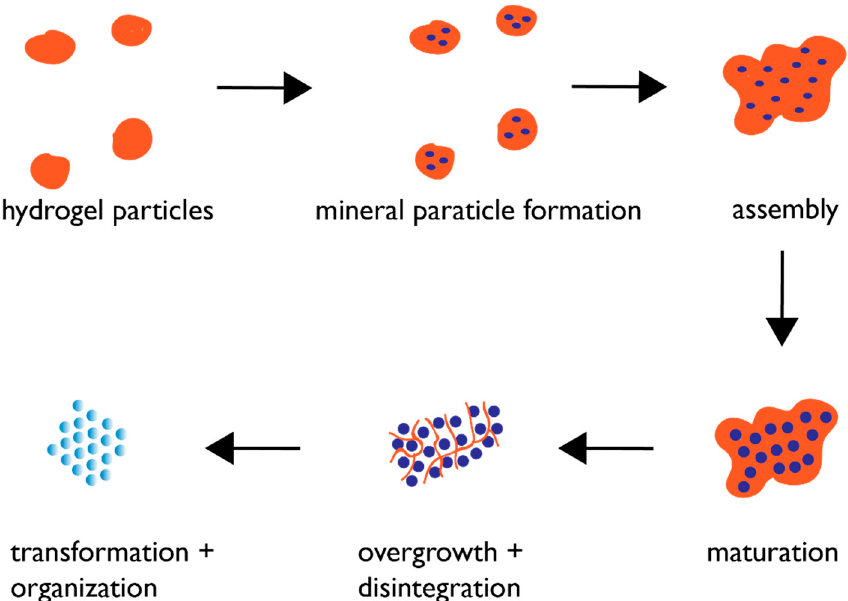
Figure 3. Proposed protein hydrogel pathway for biogenic mesocrystal formation. Blue circles denote mineral nanoparticles. Maturation stage refers to the growth of the ACC nanoparticles to permissible dimensions within the hydrogel matrix. The overgrowth and disintegration stages refer to the continued mineral growth and simultaneous protease degradation of the hydrogel matrix, resulting in matrix capture within the mineral nanoparticles as intracrystalline organic nanoinclusions.